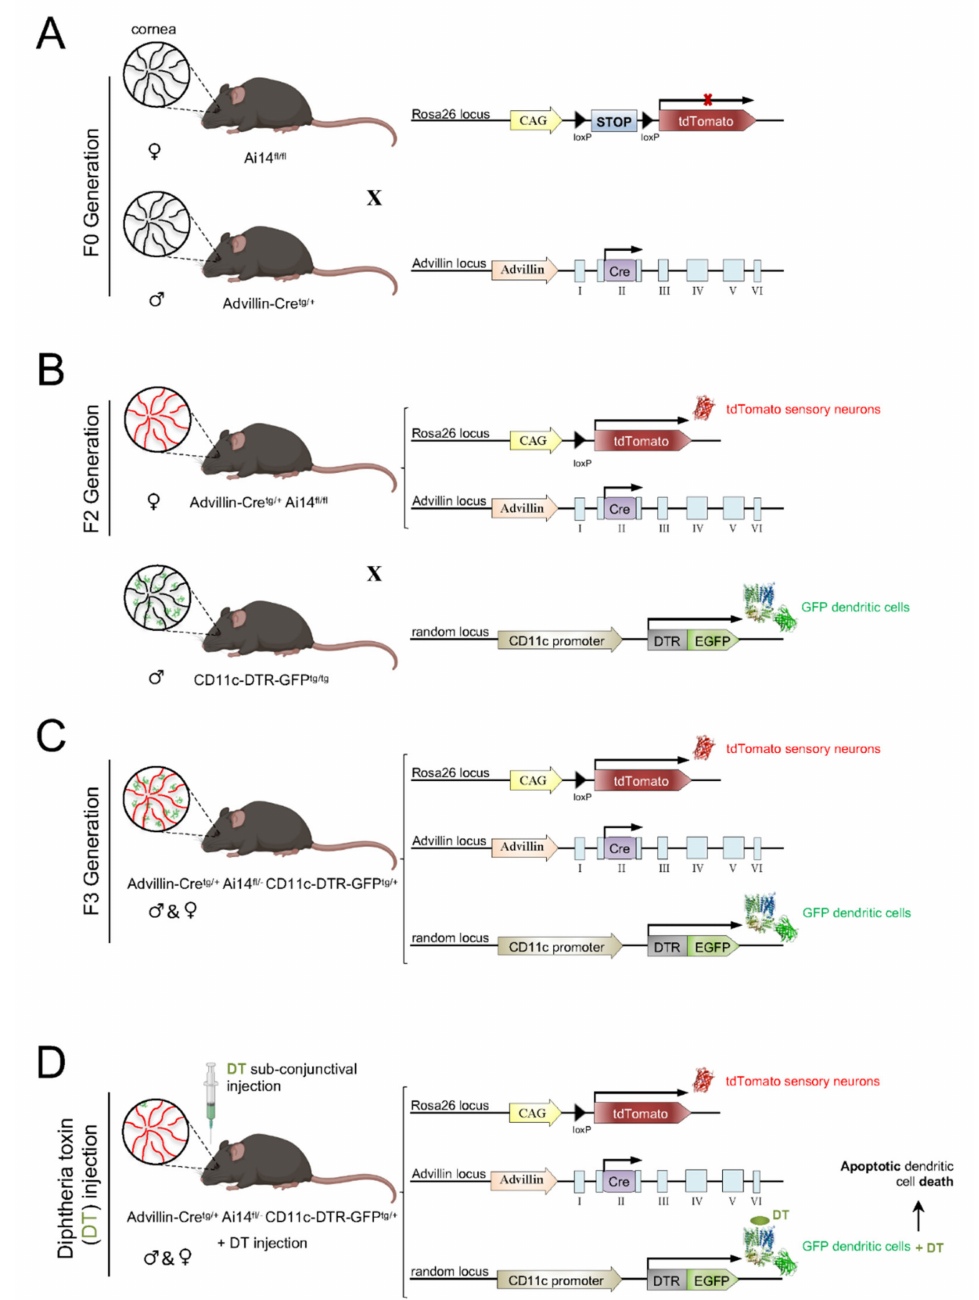
Figure 7. Scheme of the generation of the Advillin-Cretg/+ Ai14fl/- CD11c-DTR-GFPtg/+ mouse model. Ai14fl/fl females were crossed with Avidillin-Cretg/+ males to produce the F1 generation ( A ). To obtain a F2 generation of Advillin-Cretg/+ Ai14fl/fl mice ( B ), F1 females were crossed with Ai14fl/fl males (which had corneal sensory nerves framed with tdTomato). To generate the animal model of interest ( C ), F2 females were crossed with male CD11c-DTR-GFPtg/tg mice that expressed Diphtheria toxin Receptor (DTR) and GFP in DCs. Subconjunctival administration of DT to the resultant Advillin-Cretg/+ Ai14fl/ − CD11c-DTR-GFPtg/+ mice caused apoptosis of corneal DCs ( D